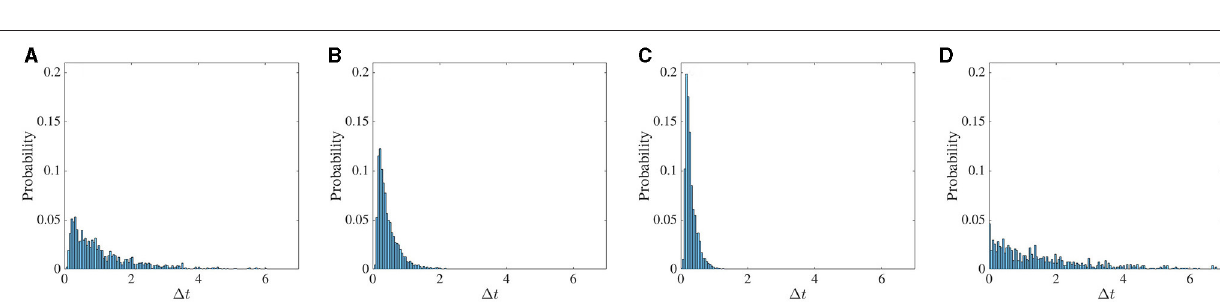
5. The top rows show that the −